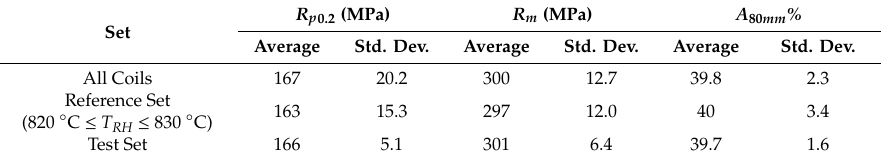
Table 8. Results of the on-line tests for Steel Code A and thickness range 2 (0.7–0.9 mm).